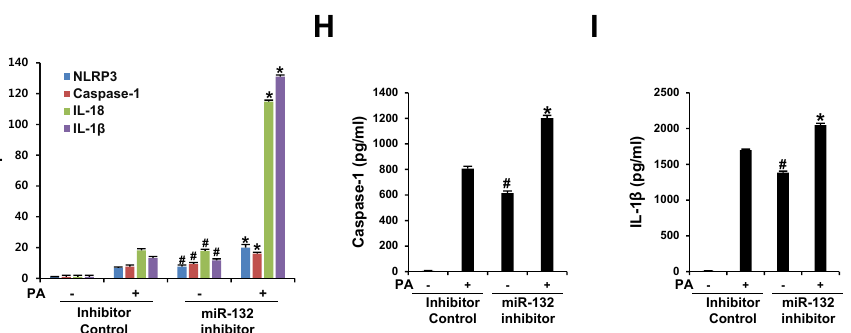
Figure 3. miR-132 regulates PA-induced NLRP3 inflammasome activation. ( A – F ) THP-1 cells were transfected with a mimic negative control, mimic, inhibitor negative control, or inhibitor of miR-132 at 20 nM for 48 h before being treated with 200 µ M PA for 12 h; ( A , C ) The mRNA levels of NLRP3, caspase-1, IL-18, and IL-1 β were examined by quantitative RT-PCR; ( B , D ) Cell lysates and supernatants were subjected to Western blot analysis using antibodies specific for NLRP3, caspase-1, IL-18, IL-1 β , and β -actin. β -Actin was used as a loading control; ( E , F ) The levels of caspase-1 and IL-1 β in the culture supernatants were determined by ELISA; ( G – I ) Primary murine macrophages were transfected with inhibitor negative control or inhibitor of miR-132 at 20 nM for 48 h before being treated with 200 µ M PA for 12 h; ( G ) The mRNA levels of NLRP3, caspase-1, IL-18, and IL-1 β were determined using quantitative RT-PCR; ( H , I ) The levels of caspase-1 and IL-1 β in the culture supernatants were determined by ELISA. # p < 0.05 compared with the mimic or inhibitor negative control in PA-untreated cells, and * p < 0.05 compared with the mimic or inhibitor negative control in PA-treated